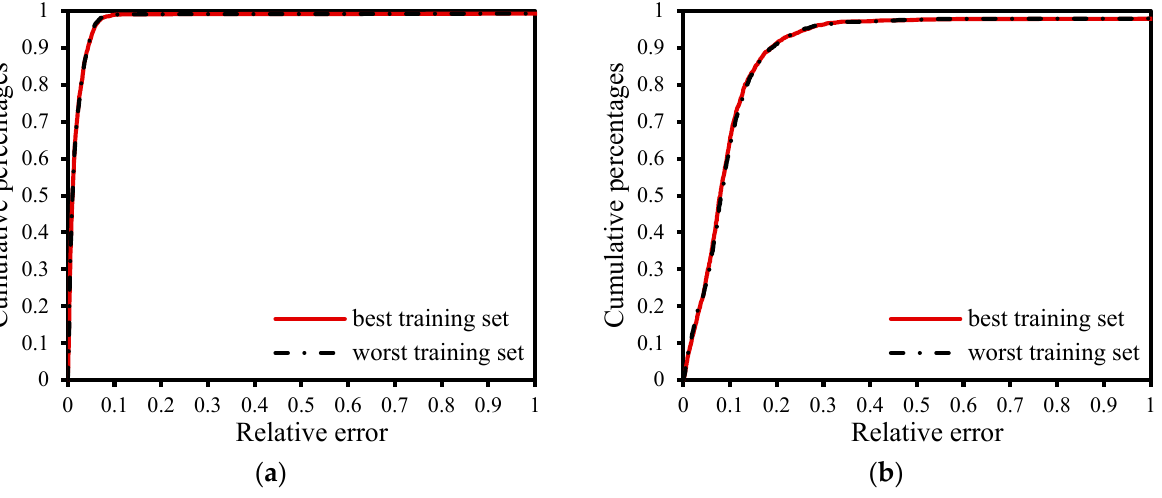
Figure 8. Building B: the probability cumulative curve of the samples at different relative error levels. ( a ) Cooling season. ( b ) Heating season. Table 10. Electricity consumption disaggregation results of HVAC terminal units.